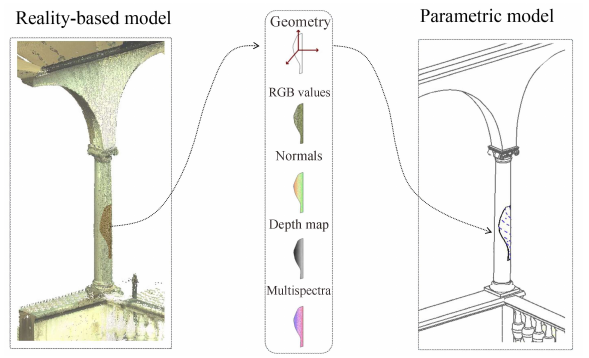
Figure 2. Decay mapping on reality-based and parametric models